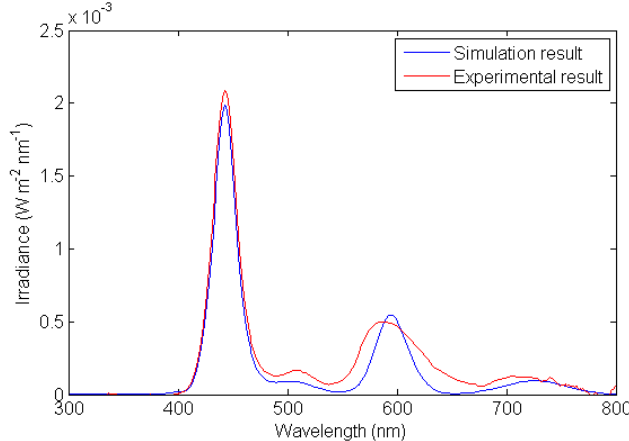
Figure 17. Simulation result versus experimental result for the case with mirrors.